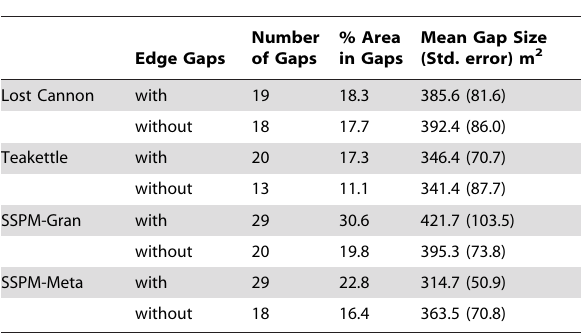
Table 5. Forest gap characteristics in old-growth Jeffrey pine- mixed conifer forests in California and northwestern Mexico, where summaries were calculated in two ways: all gaps within the four ha study area (with edge gaps), and excluding gaps where more than 10% of the gap area overlapped the 5 m perimeter buffer (without edge